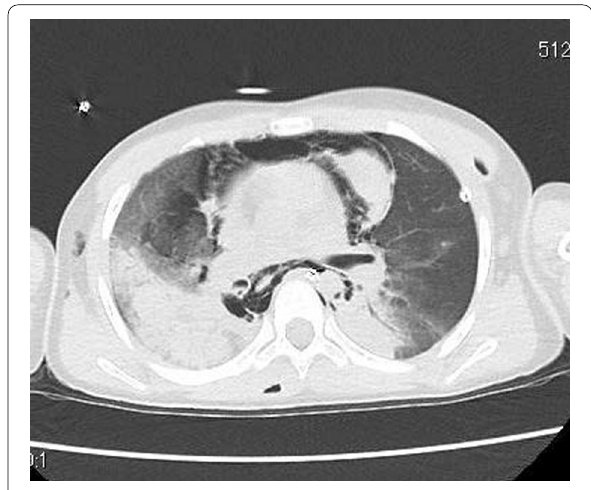
Fig. 1 Computed tomography image obtained before surgery showing injury of the tracheal bifurcation, and the right and left main bronchi